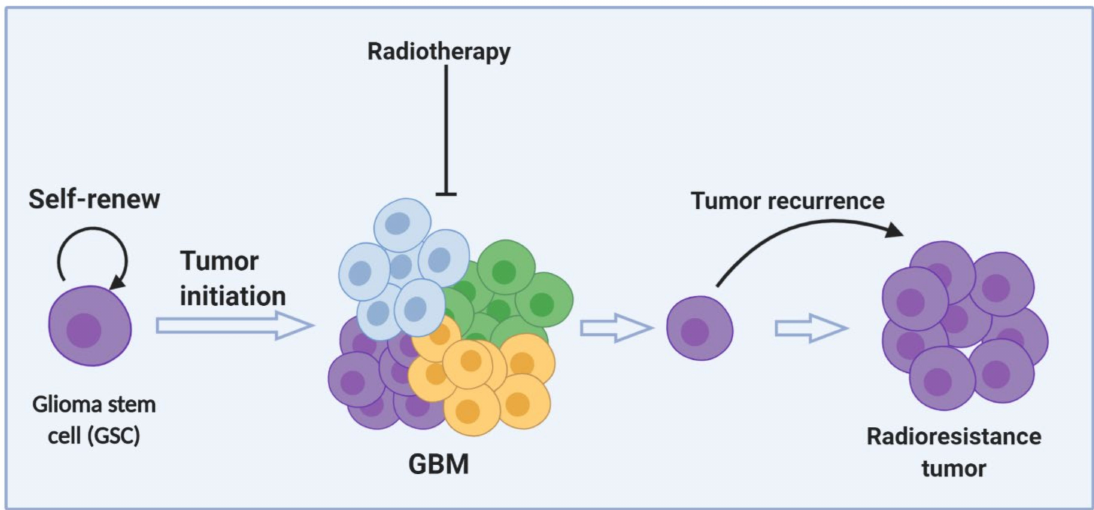
Figure 3. GSCs can self-renew, initiate tumors, and survive radiotherapy. The cells that survive radiotherapy can give rise to a population of cells that are resistant to radiation. Created with BioRender (Science Suite Inc., Toronto, Ontario,